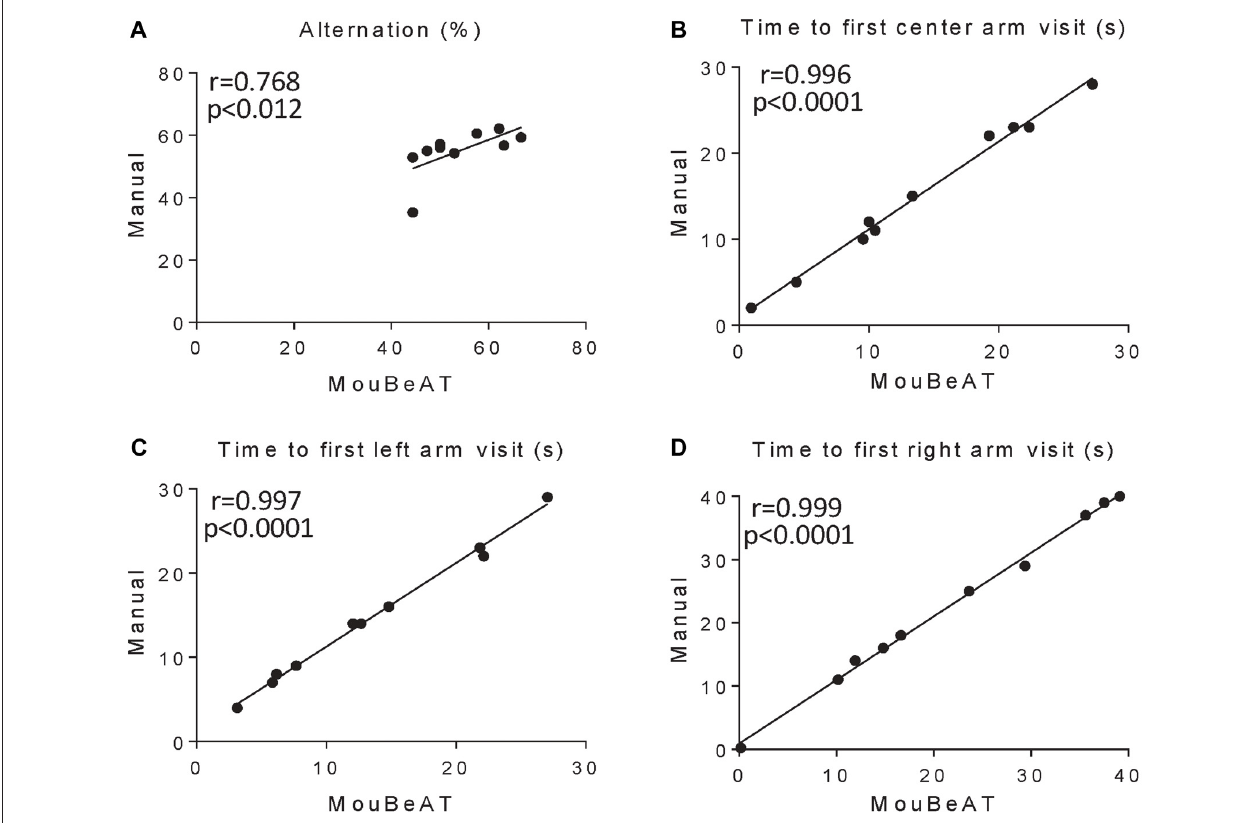
FIGURE 5 | Correlation of arm alternation and time to visit each arm in the YM test between MouBeAT and manual observation. The YM test was performed using 10 C57BL/6J male mice. Each dot represents the percentage of alternation between arms (A) , and the time it took each mouse to visit the center (B) , left (C) and right (D) arms for the first time. For (A) the Spearman correlation coefficient was